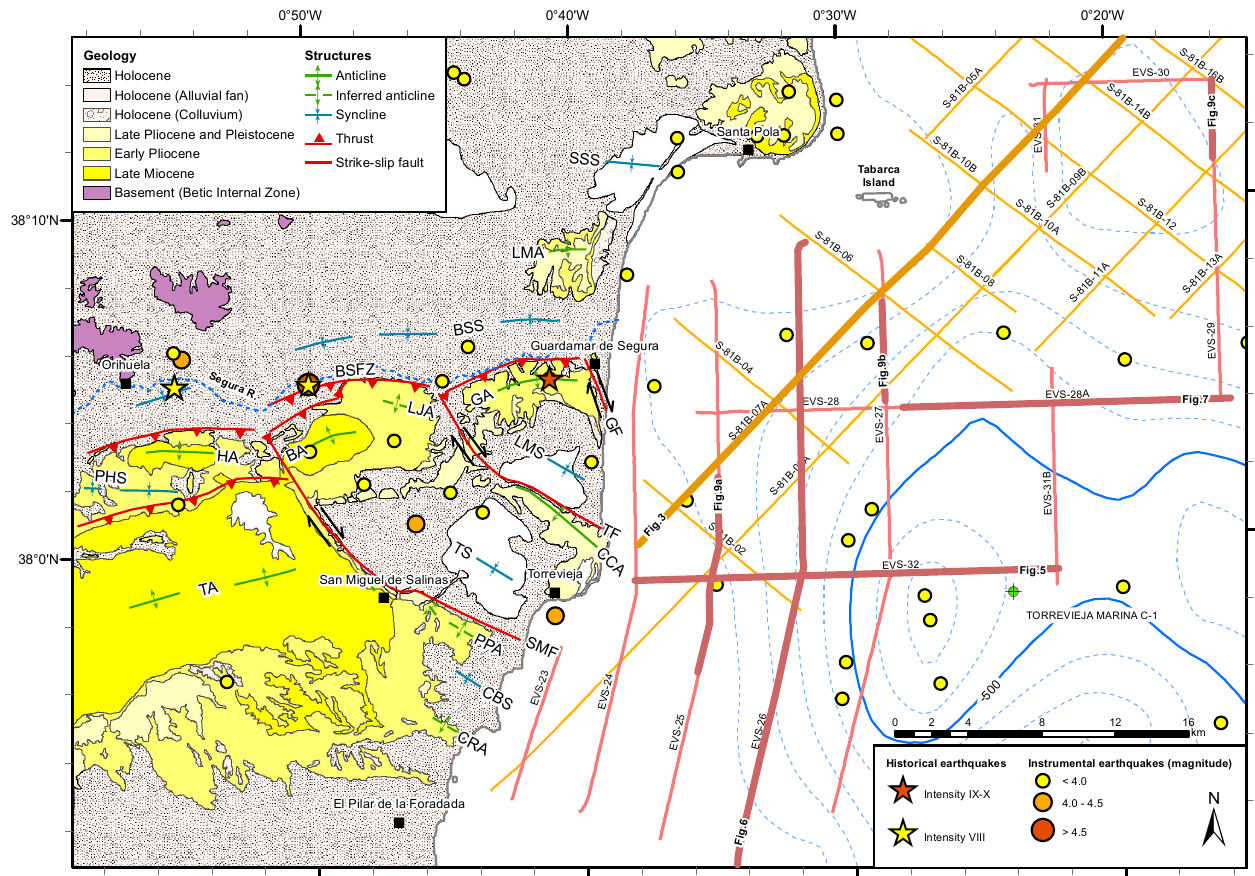
Fig. 2. Bathymetric (dashed blue lines with contour interval 100m) and geological (Alfaro et al., 2002a, b) map of the Bajo Segura basin. Stars and dots show the historical and instrumental epicenters, respectively (IGN, 2011). Orange lines correspond to commercial MCS profiles (survey S-81B 25/81; Archivo T´ecnico de Hidrocarburos, 2012) and pink lines to SCS sparker profiles obtained during the EVENT- SHELF cruise. Fault kinematics refers to Upper Neogene. Faults: BSFZ: Bajo Segura fault zone; GF: Guardamar fault; SMF: San Miguel de Salinas fault; TF: Torrevieja fault. Folds: BA: Benej´uzar anticline; BSS: Bajo Segura syncline; CBS: Cala del Bosque syncline;